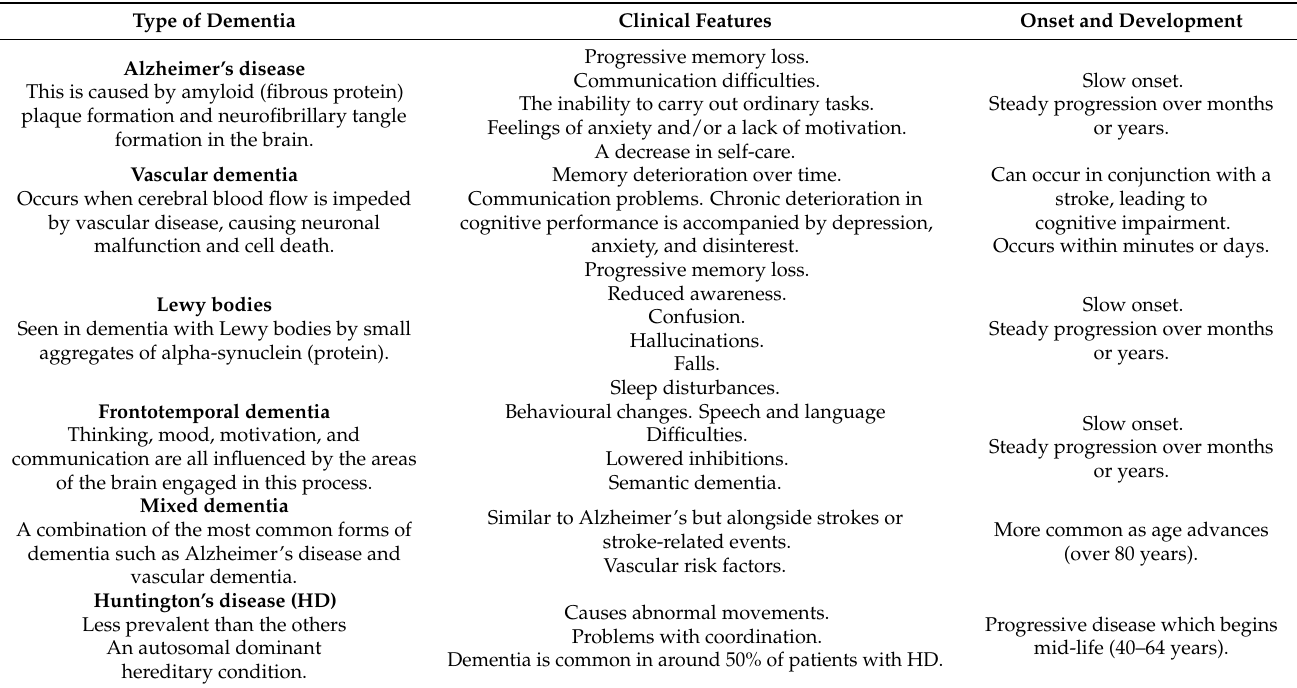
Table 1. The different types of dementia and their clinical characteristics, including disease onset and progression